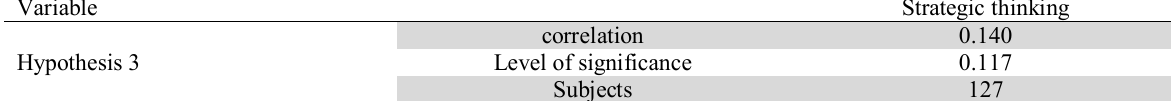
The results of Pearson correlation for the third hypothesis (Verbal/linguistic intelligence)